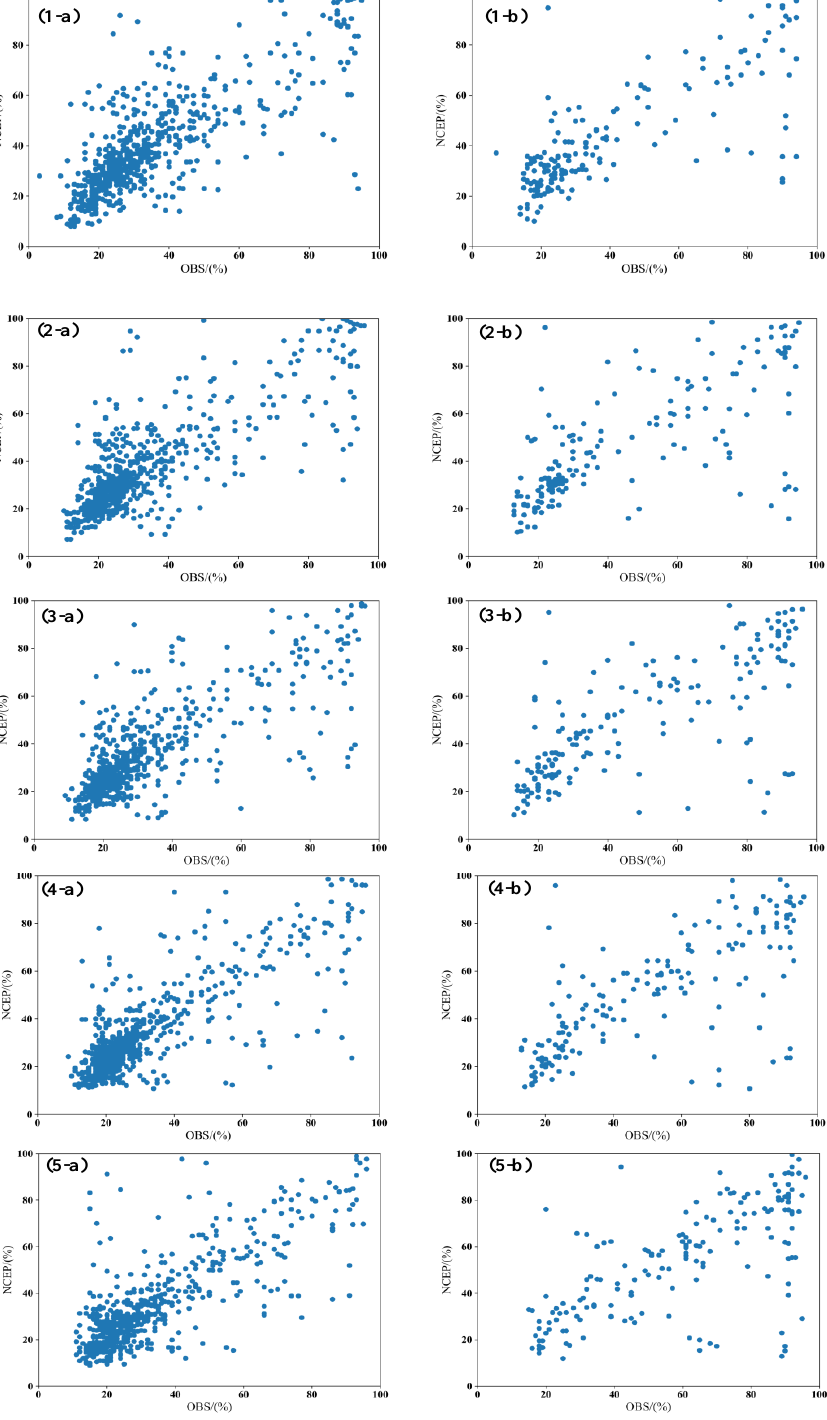
Figure 6. Correlation of the relative humidity between the observations and the NCEP/FNL reanalysis data at ( 1 ) 850, ( 2 ) 900, ( 3 ) 925, ( 4 ) 950, and ( 5 ) 1000 hPa during the ( a ) clean days and ( b ) polluted days.